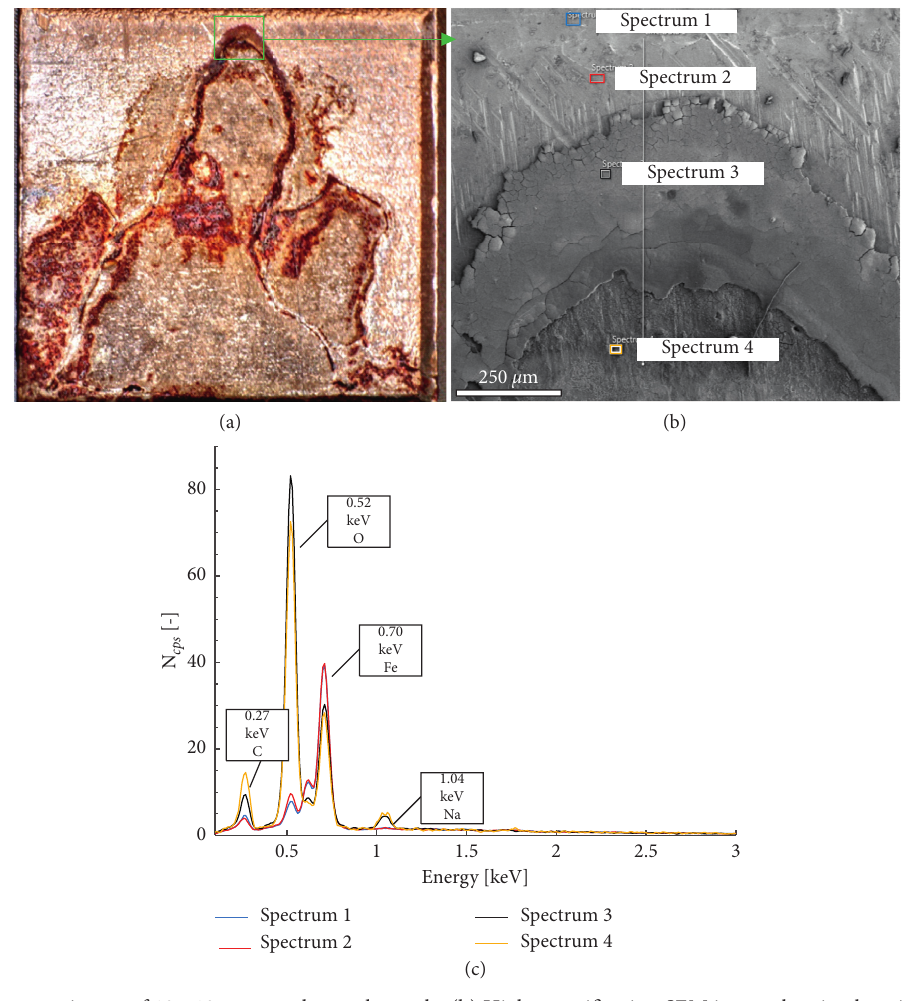
Figure 1: (a) Microscope image of 10 × 10 mm regular steel sample. (b) High magnification SEM image showing location of EDS analysed regions. (c) Results of EDS analysis confirming corrosion by detection of Na and O in spectra 3 and 4.